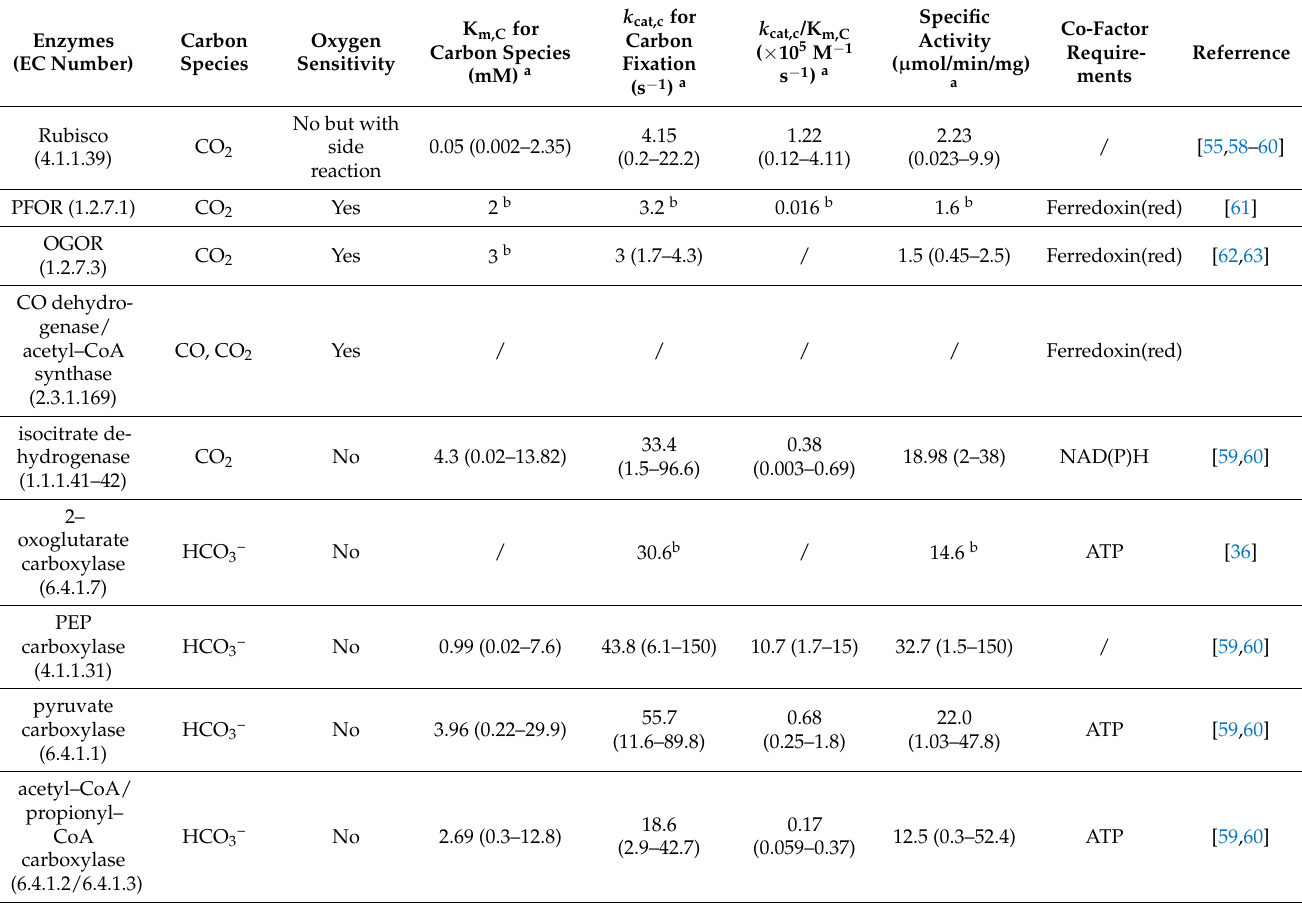
Table 1. Carbon dioxide fixation enzymes in natural carbon fixation